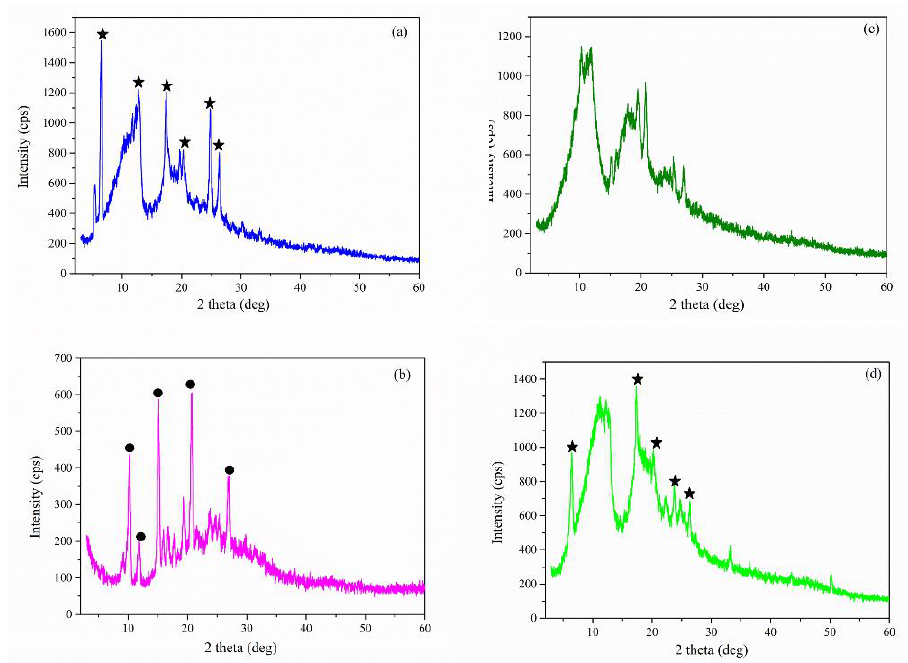
Figure 10. XRD pattern of ( a ) Nim – Me- β -CD physical mixture; ( b ) Nim – Me- β -CD coprecipitation method; ( c ) Nim–Me- β -CD lyophilization method; ( d ) Nim–Me- β -CD kneading method ( —Nim method; ( c ) Nim – Me- β -CD lyophilization method; ( d ) Nim – Me- β -CD kneading method ( — Nim mod I; —Nim mod mod I; — Nim mod II).